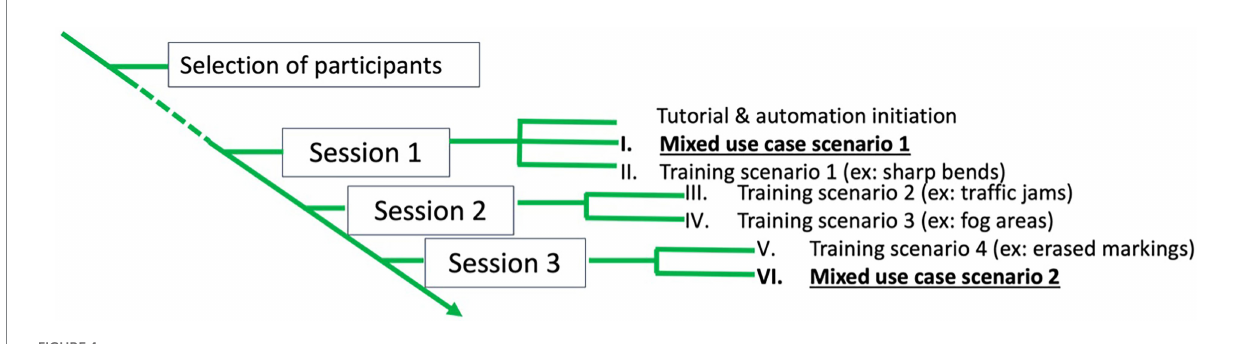
FIGURE 4 Representation of the procedure of the